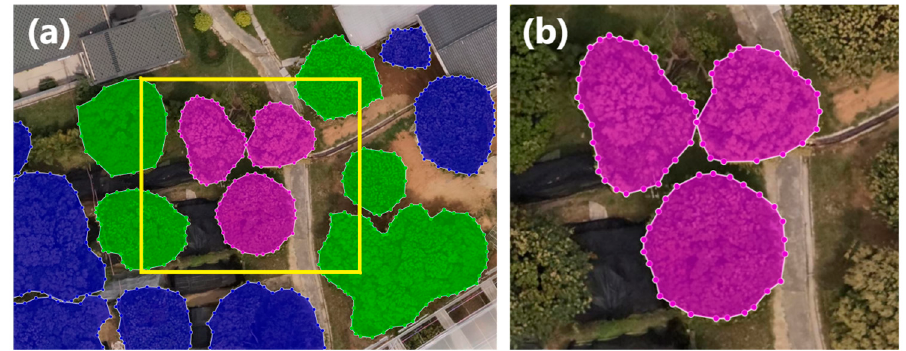
Figure 5. Illustration of crop sampling. ( a ) Objects are colored based on the relationship with the cropping frame in the yellow color: pink means that the whole object is inside the frame; green indicates that the object is partly inside the frame; blue means the object is outside the frame. ( b ) Only the objects which are the whole inside the frame are chosen as objects in the sampling process.